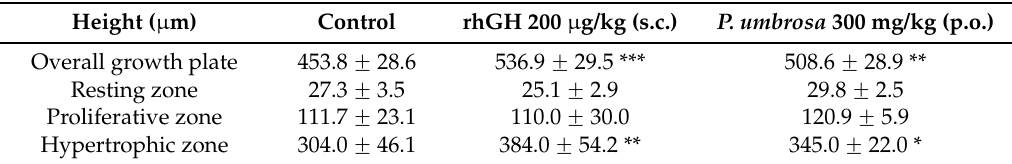
Table 1. Zonal height of each group in growth plate of proximal tibia in rats.